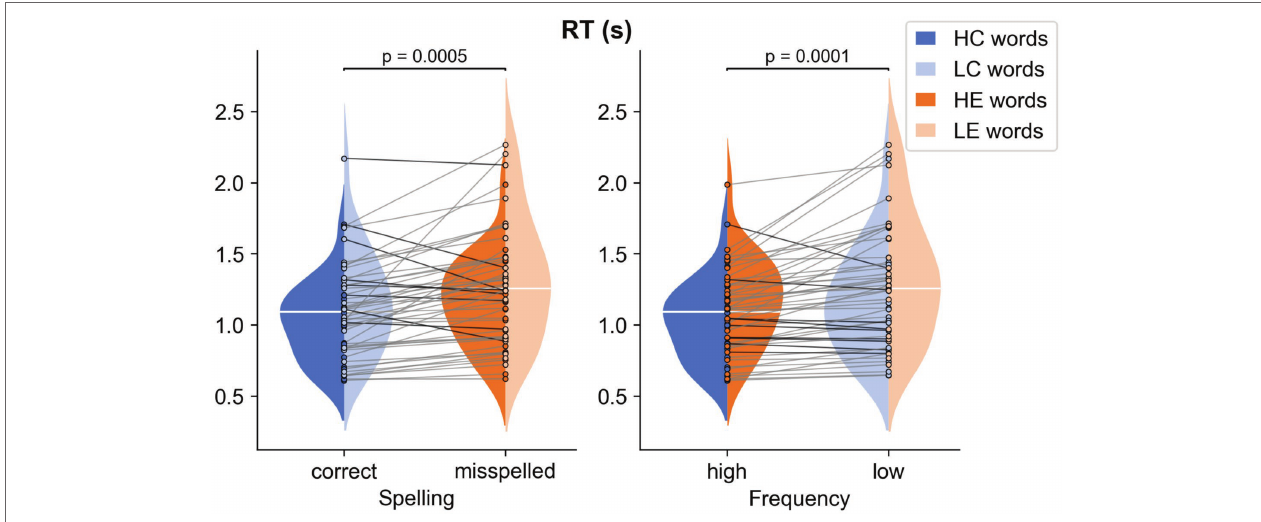
FIGURE 2 | RM ANOVA results for response times (RT). The distributions of the RT for the four types of stimuli are displayed by a violin plot, means are shown as horizontal white lines.